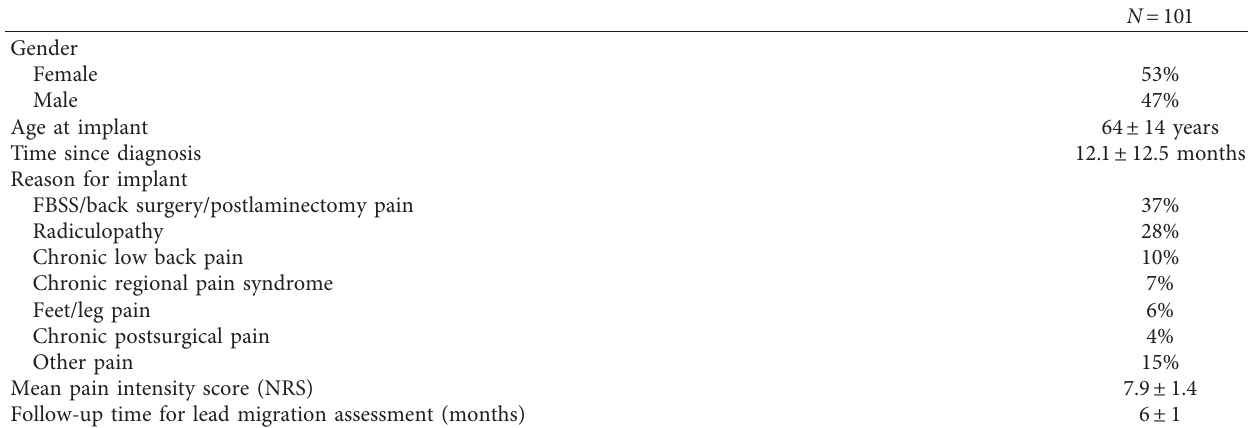
Table 1: Demographics and clinical characteristics at